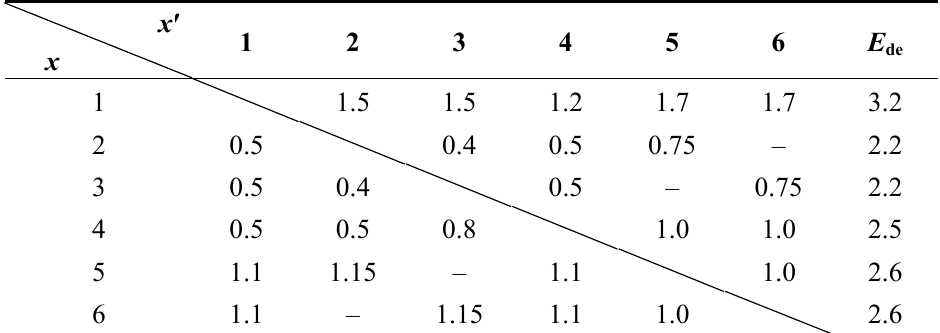
Table 3. The migration barriers from x to x ′ site, Δ E ( x → x ′ ), and desorption energies, E ( x ), from the x site de